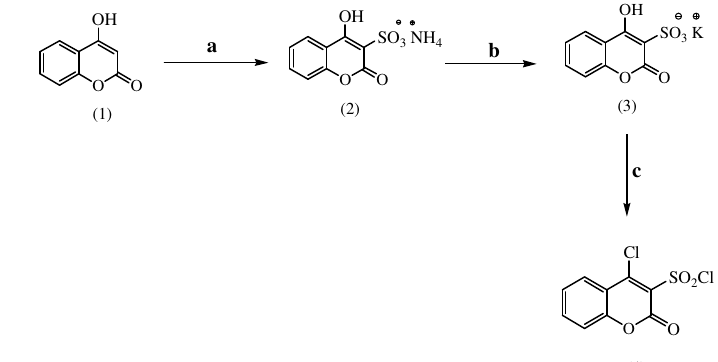
Figure 1. Synthesis of 4-chloro-2-oxo-2 H -chromene-3-sulfonyl chloride (4) Reagents: (a) ClSO H, NH (b) 4% KOH, (c) POCl 3 3